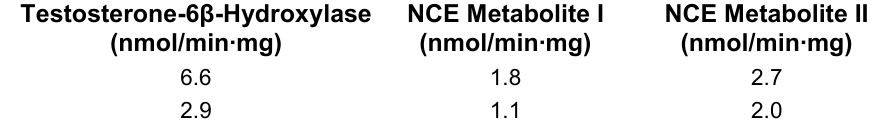
Effect of Specific Antibodies on the CYP3A4 Activity and on the Synthesis of